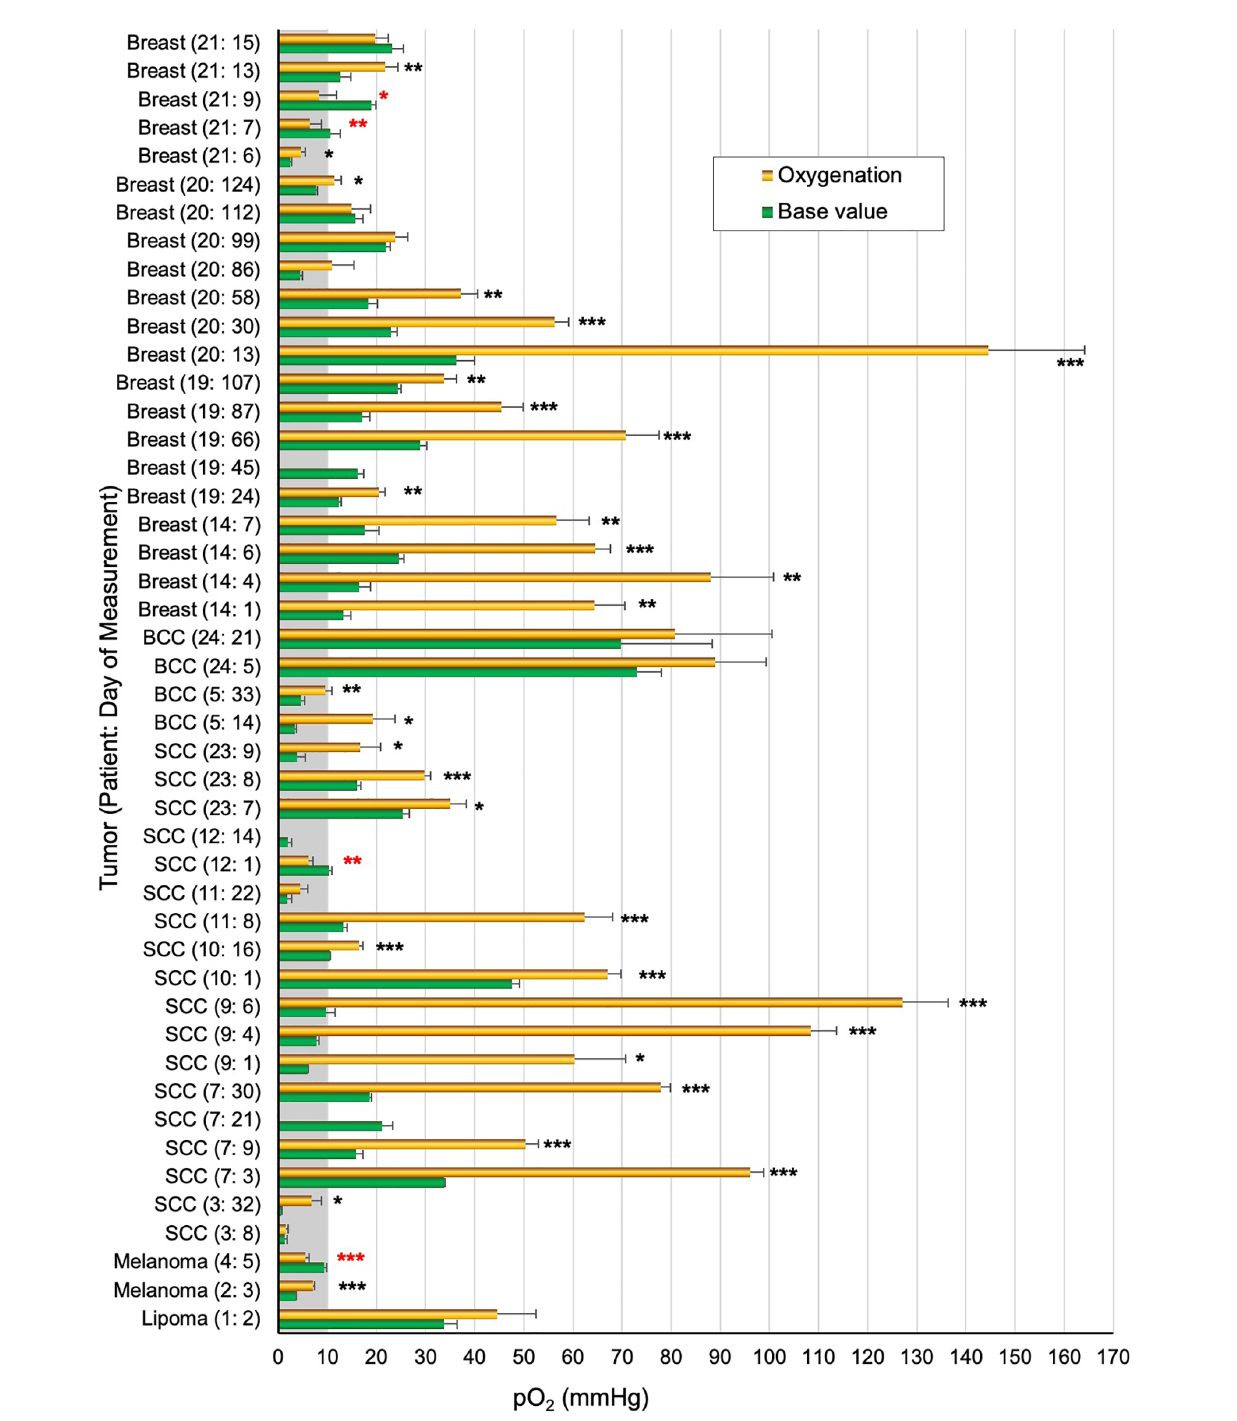
FIGURE 4 | Tumor pO 2 values in patients breathing room air and hyperoxygen gas. The pO 2 values (mean ± SEM) obtained before initiation of hyperoxygenation (Base value) and after hyperoxygenation (Hyperoxygenation) in a total of 46 measurements from 16 patients. For each measurement the tumor type, patient number, and measurement day relative to initial implantation are noted, i.e. “ Breast (21:5) ” indicates that patient 21 had a breast malignancy and this measurement occurred on day 5 after OxyChip implantation. Multiple measurements from the same patient are thus indicated by different days relative to OxyChip implantation. Statistical signi fi cance data (unpaired t-test) between base and hyperoxygenation pO 2 values for each patient/measurement are grouped as * P ≤ 0.05; ** P <0.01; *** P <0.001 (actual P values are in Table 1 ). A red-colored * denotes signi fi cantly negative response to